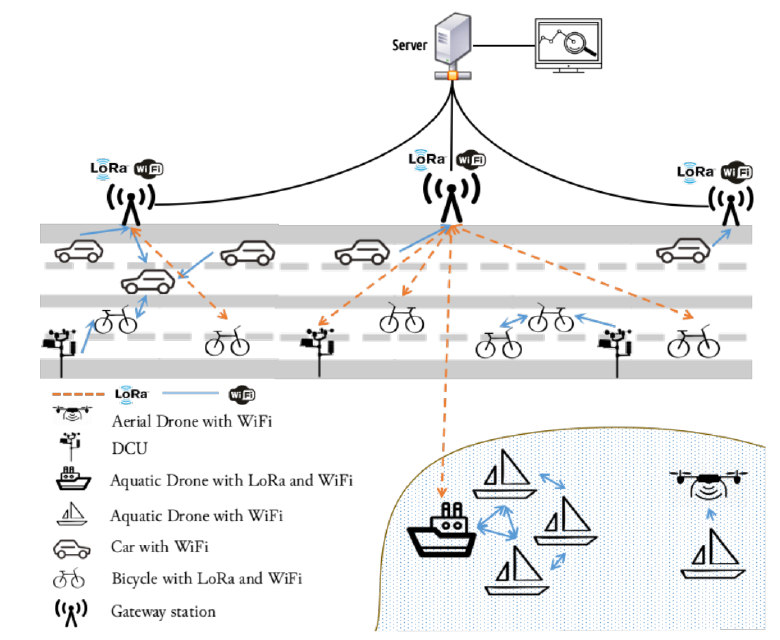
Figure 2. City-wide platform overview [16].